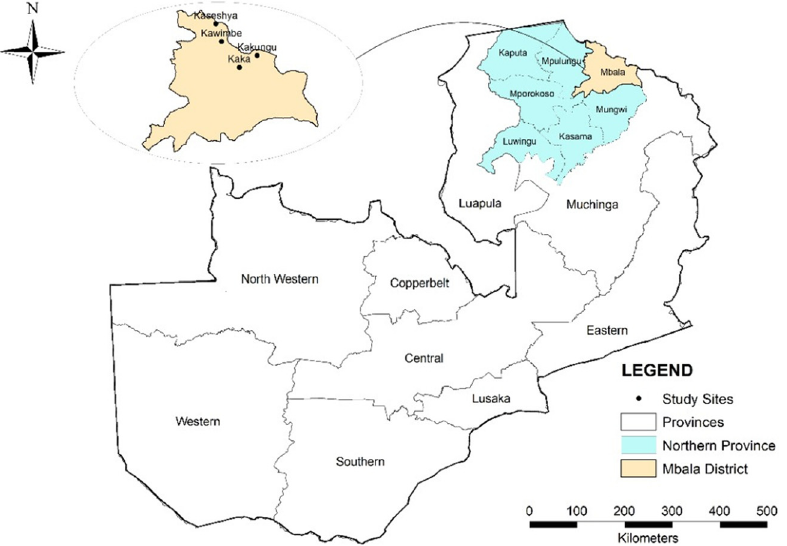
Figure 1: Map of Zambia showing agricultural camps in Mbala district, northern Zambia, used in the survey conducted in August